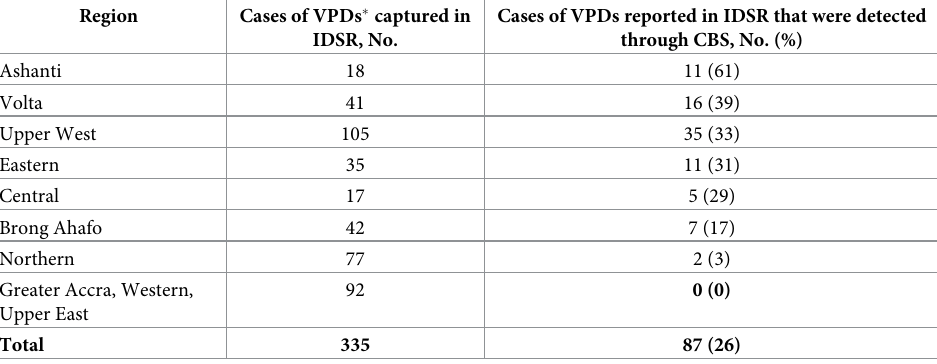
Table 4. Number and percentage of cases of VPDs captured in IDSR that were detected through modified CBS, September 2018–March 2019. Region Cases of VPDs � captured in IDSR,